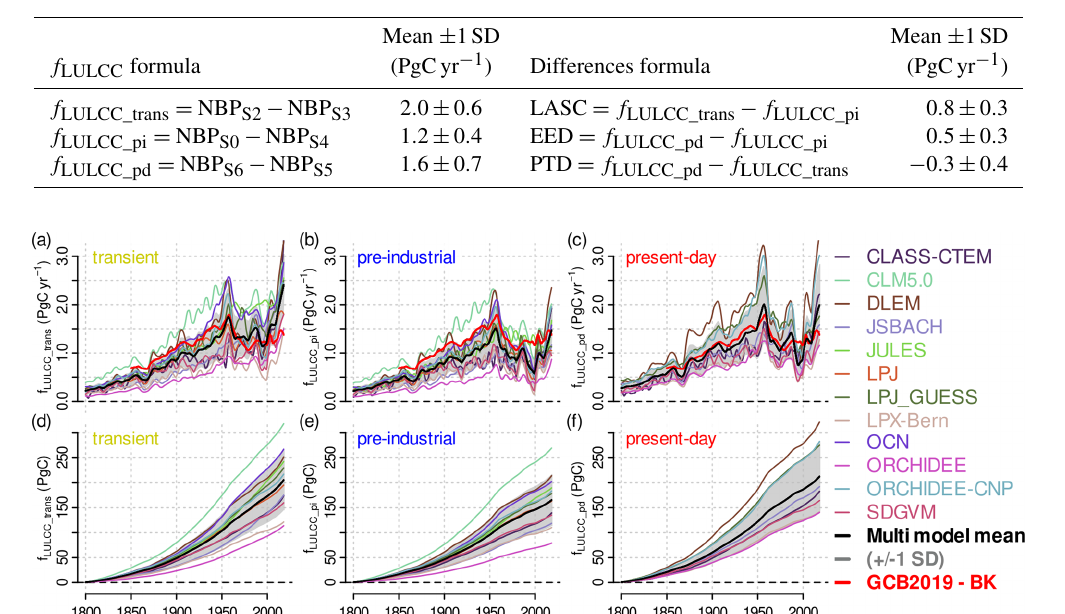
Table 3. Overview of global annual f LULCC estimates and their differences (loss of additional sink capacity, LASC; “present-day” vs. “tran- sient” environmental conditions difference, PTD; environmental equilibrium difference, EED) for the time period 2009–2018. Mean and standard deviation refer to the DGVM model ensemble.